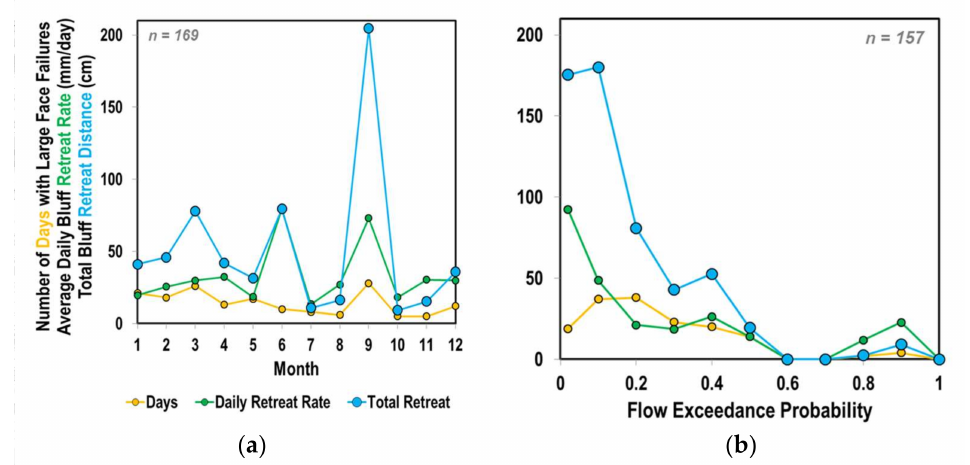
Figure 6. ( a ) Large face failure frequency (total number of days per month), average daily retreat rate for a 250 ± 95 m 2 bluff in a given month, and their product, total bluff retreat, measured across 20 time lapse photo monitored sites, 169 total observations. ( b ) Same data as 6a, only plotted against daily flow exceedance probability. Data binned every 10 percentiles except percentiles binned 0–2 and 2–10. Data binned as 0–0.02 exceedance probability only include June 2014 and September 2016 flood peaks, when 12% of all large failures occurred. Total bluff face erosion during the two flood peaks account for 45% of all face erosion from June 2014–May 2017. Data represented by one hundred fifty seven total observations since 12 large face failures occurred when daily flow data were unavailable due to